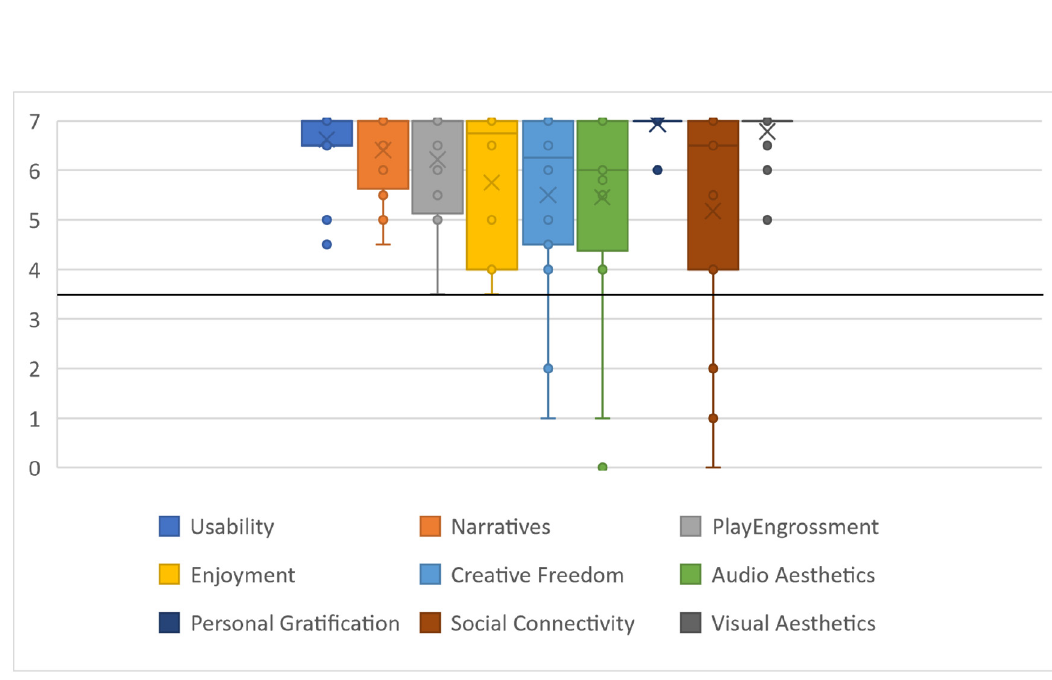
Fig 8. Boxplot distribution of GUESS-18 subscales.